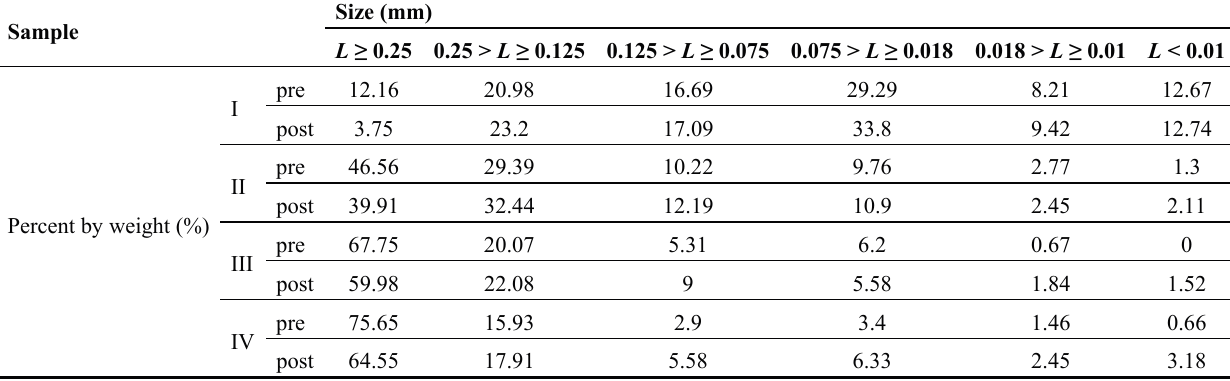
Table 6. PSDs of the tailings pre- and